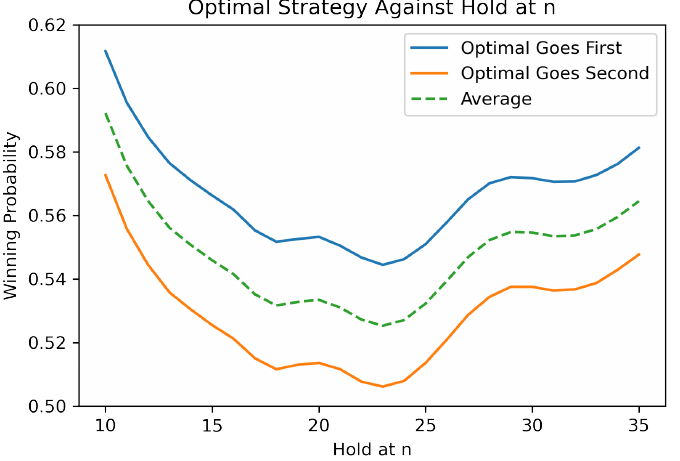
Figure 6. Winning probabilities of the optimal strategy developed in this work against the traditional “hold at n” strategy for the standard two-dice Pig